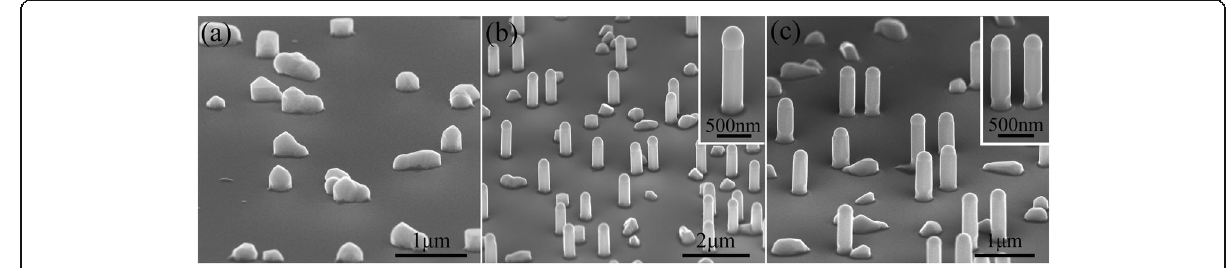
Fig. 4 The 80°-tilted SEM images of the GaSb nanowires grown without InAs stems ( a ), and on the short InAs stems ( b , c ). The GaSb nanowires shown in a and b were grown at 500 °C, while the GaSb nanowires in c were grown at 520 °C. Insets in b and c show higher magnification SEM images